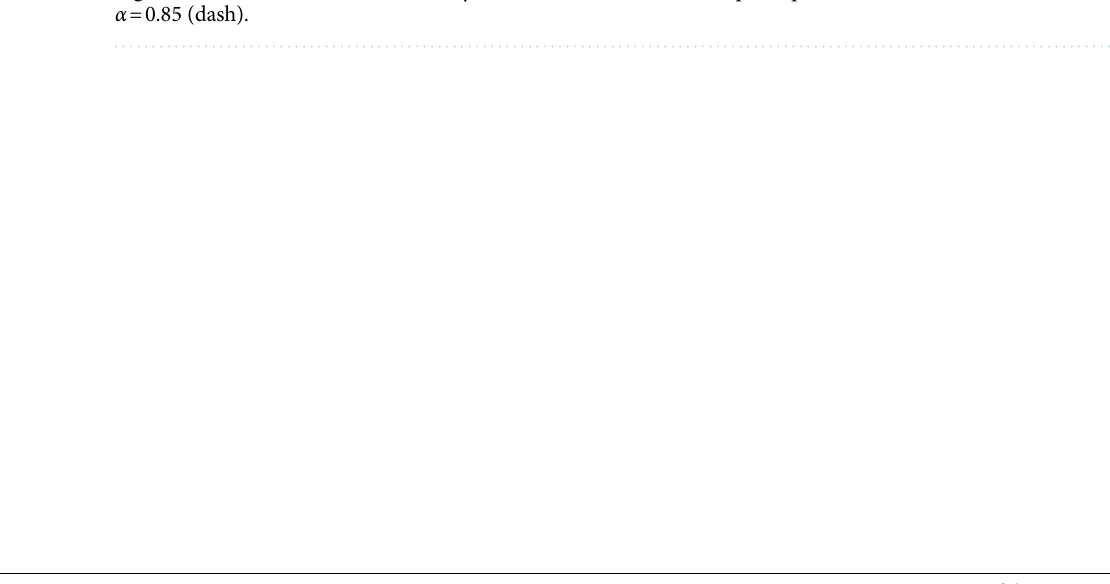
Figure 8. The case’s chaotic attractor dynamics, shown in 2D and 3D phase portraits when α = 1 (line) and α = 0.85